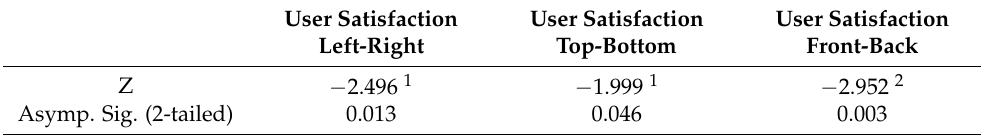
Table 4. Results of Wilcoxon signed-rank test of user satisfaction based on object